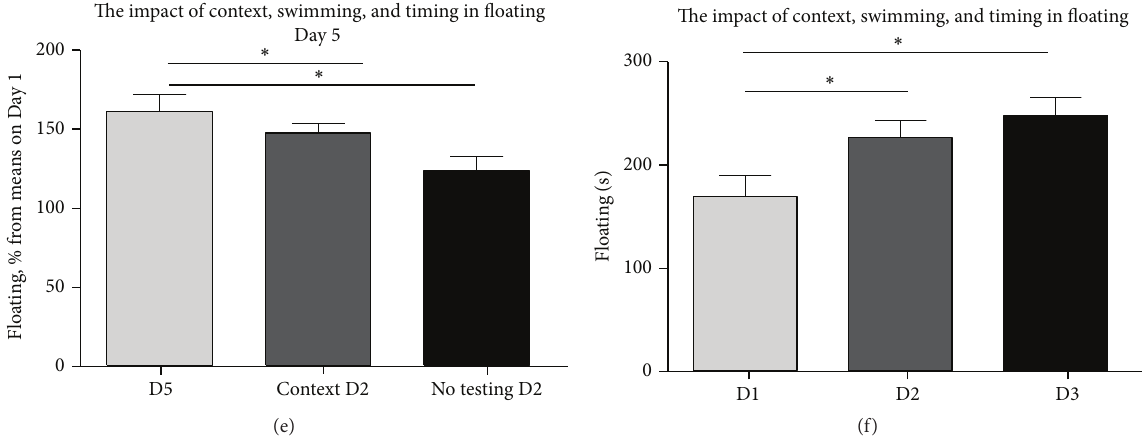
Figure 2: Behavioural changes induced in the modified swim test and the role of context, swimming, and timing of testing. (a) Mice exposed to the modified swim test ( 𝑛 = 14 ) showed an increase of total duration of floating. (b–d) An increase of duration of floating at the delayed testing session on Day 5 in comparison to the session on Day 2 was the pronounced during the first two-minute periods. (e) In comparison to the session on Day 2, mice subjected to the modified swim test have displayed significantly increased total duration of floating when the testing on Day 2 was replaced with exposure to a context of testing ( 𝑛 = 10 ) that was similar to the changes in regular modified swim test, but not when the testing on Day 2 was omitted ( 𝑛 = 9 ). Data are expressed in percent from mean values of floating on Day 1 for each group. (f) Mice displayed a significant increase in the total duration of floating on Day 3 as compared to Day 1, but not Day 2 ( 𝑛 = 10 ). ∗ 𝑝 < 0.05 , ANOVA and Tukey’s multiple comparisons test; see the text; Context D2: mice were exposed to a context of testing instead of swim session on Day 2; no testing D2: testing on Day 2 was omitted. D1: Day 1; D2: Day 2; D3: Day 3; D5: Day 5. Data are mean ±